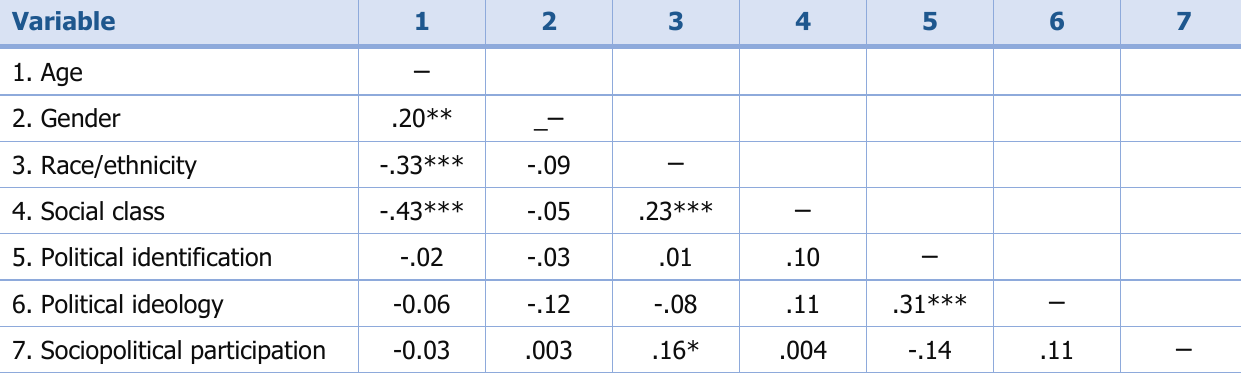
Table 2. Intercorrelations Among Main Study Variables